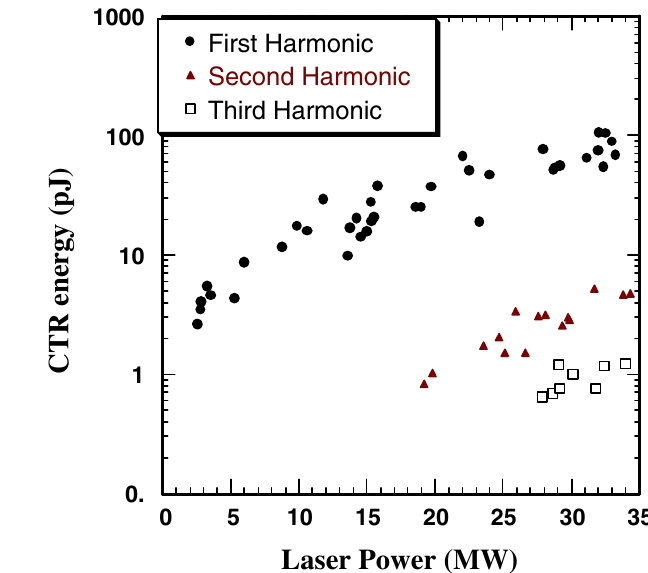
FIG. 5. (Color) CTR energy for the first (circles), second (tri- angles), and third harmonics (squares) as a function of the CO 2 laser